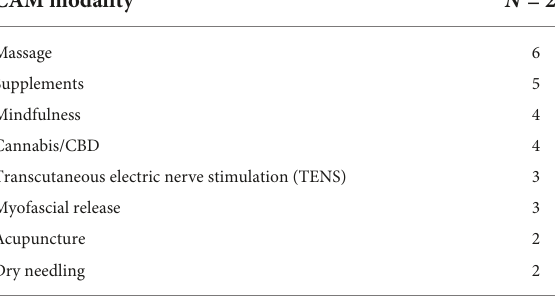
Trialed Found Found helpful unhelpful